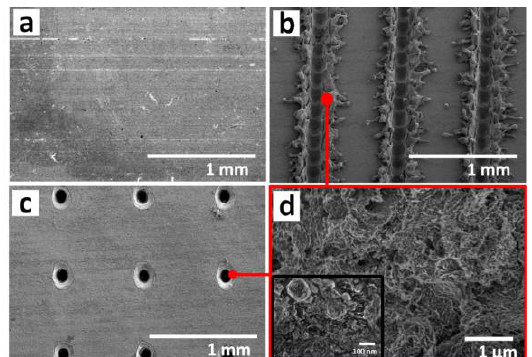
Figure 4. SEM images of different samples: ( a ) Low magnification SEM images for sample A (50×); ( b ) low magnification SEM image for sample C (50×); ( c ) low magnification SEM image for sample D; ( d ) zoom-in view of sample C and D (20,000×, 50,000×) shows the dual-scale micro/nanostructures induced by laser chemical treatment [32].